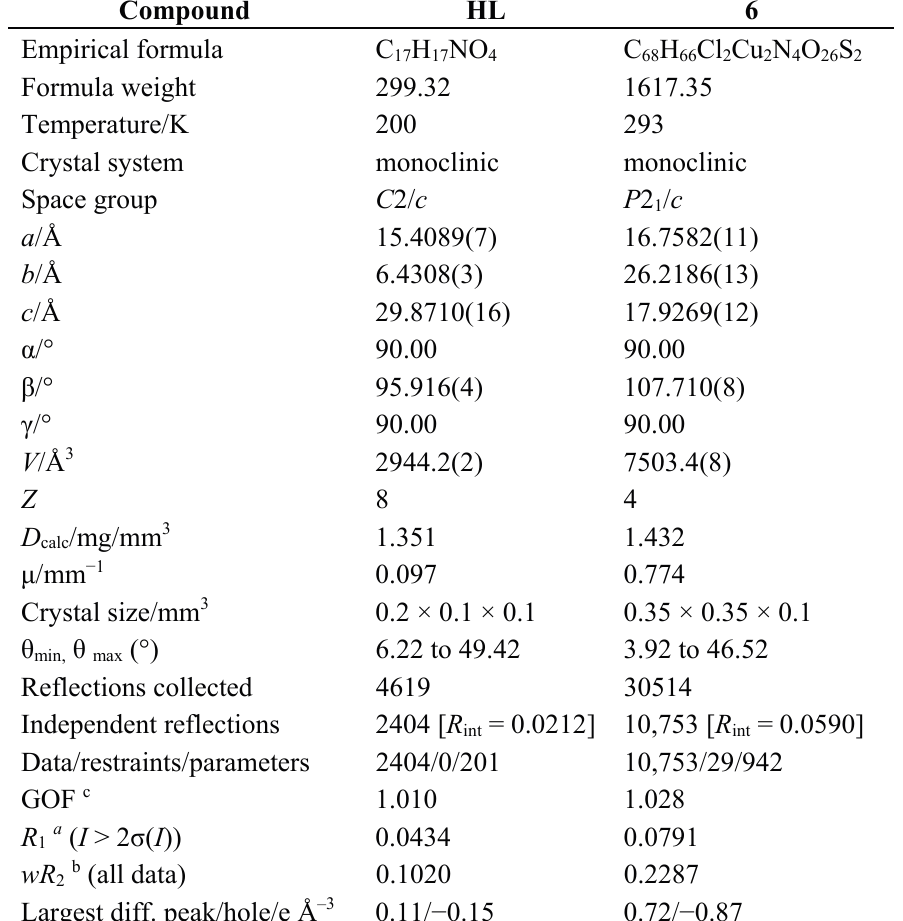
Table 6. Crystallographic data, details of data collection and structure refinement parameters for HL and 6